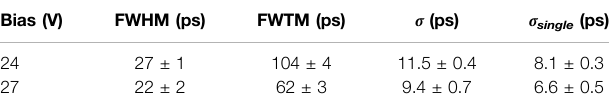
(cid:1)(cid:1) √ 2 . The errors have been evaluated using statistical error